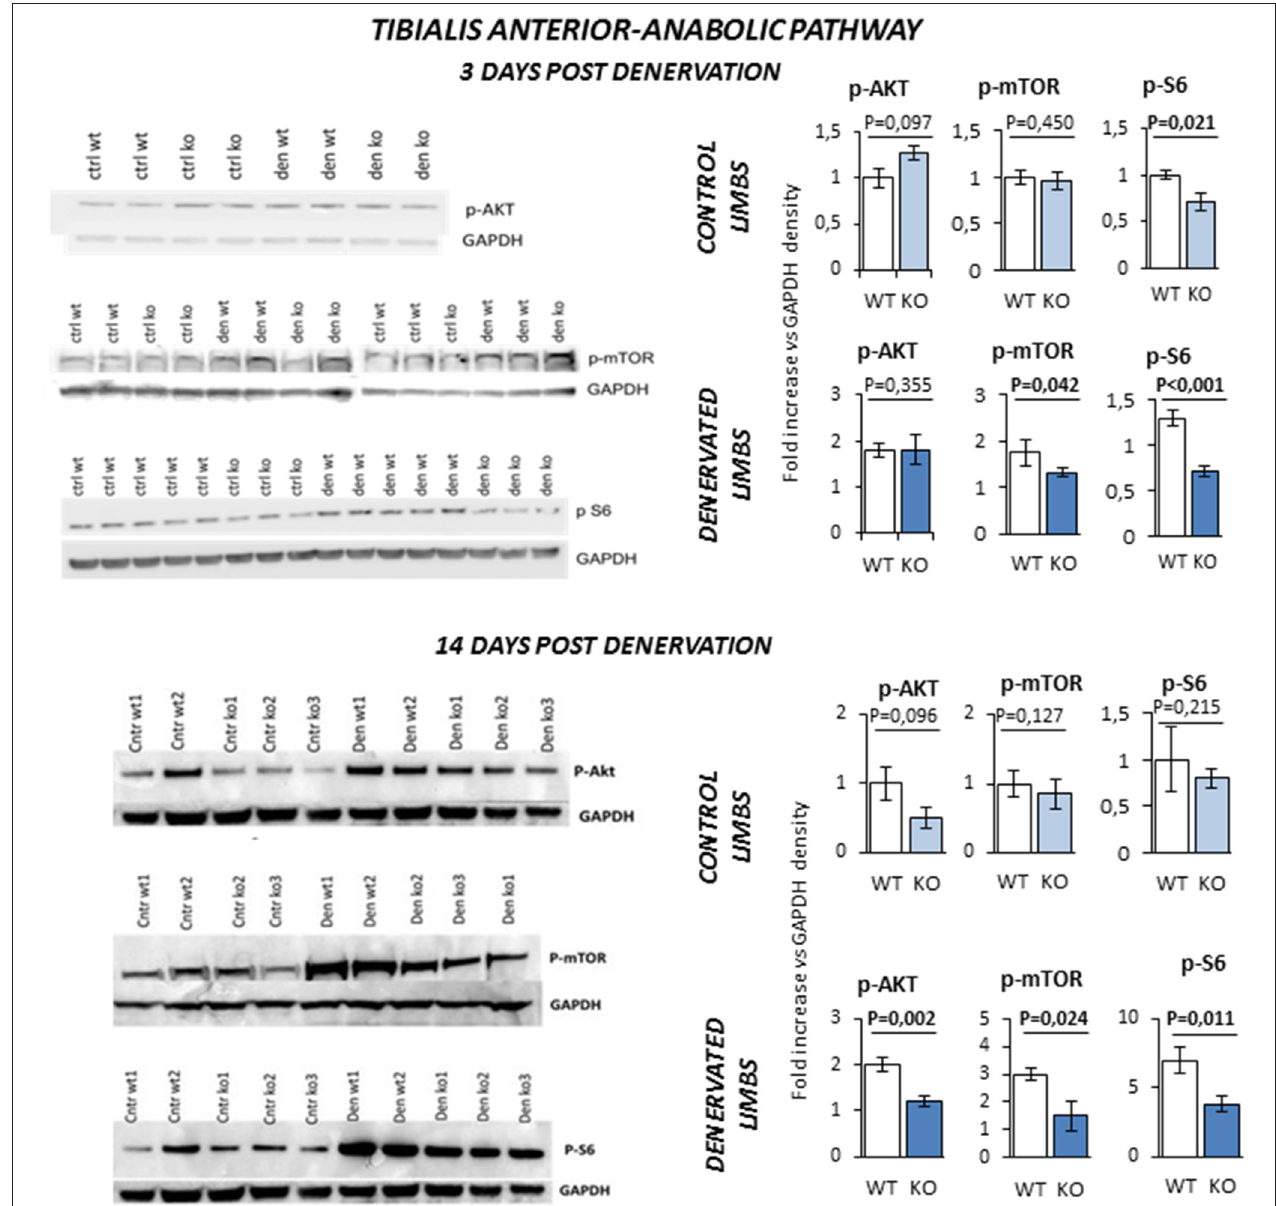
FIGURE 7 | Activation of anabolic pathway in tibialis anterior muscle specimens obtained from contralateral non-denervated (CONTROL) and denervated (DENERVATED) limbs in wild type (WT) and Rxfp2 − / − mice (KO), at both 3 (WT, N = 5; KO, N = 4) and 14 (WT, N = 6; KO, N = 5) days post-denervation. Downstream phosphorylation of AKT/mTOR/S6 pathway was monitored by western blot analysis, whose representative images are given. Target band densities were normalized on corresponding GAPDH as loading control. Data are reported as mean values ± standard error of the mean. Significance: P -values between compared conditions are reported. Significant differences ( P < 0.05) are highlighted in bold.